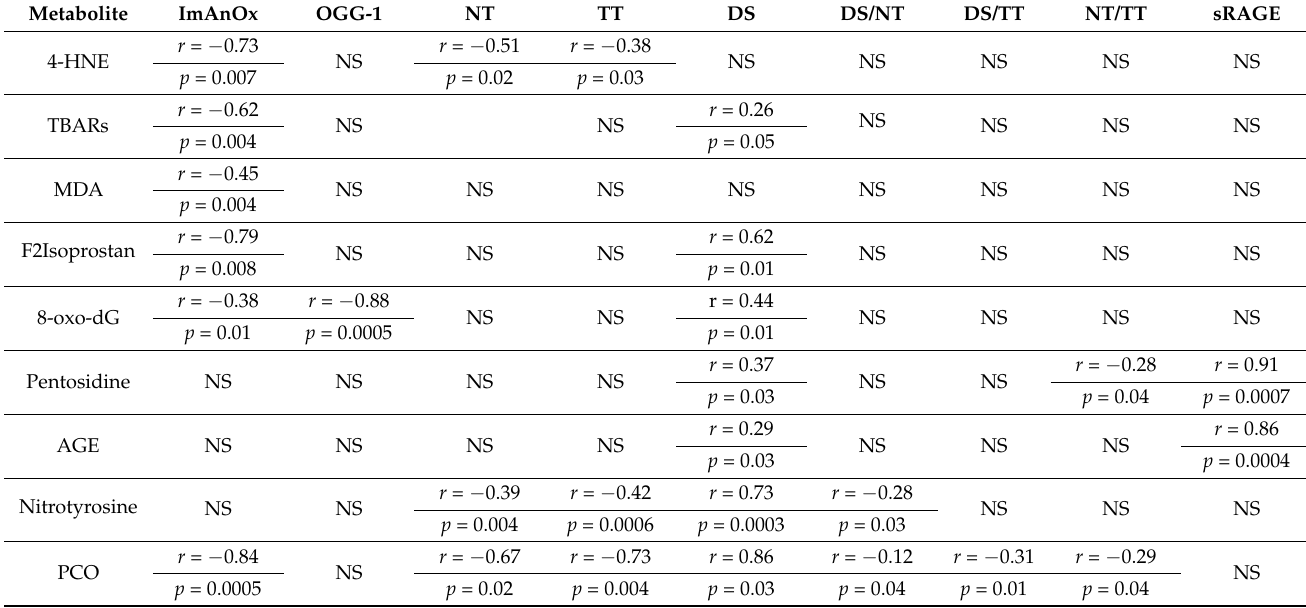
Table 8. Correlation analysis between studied parameters in LN